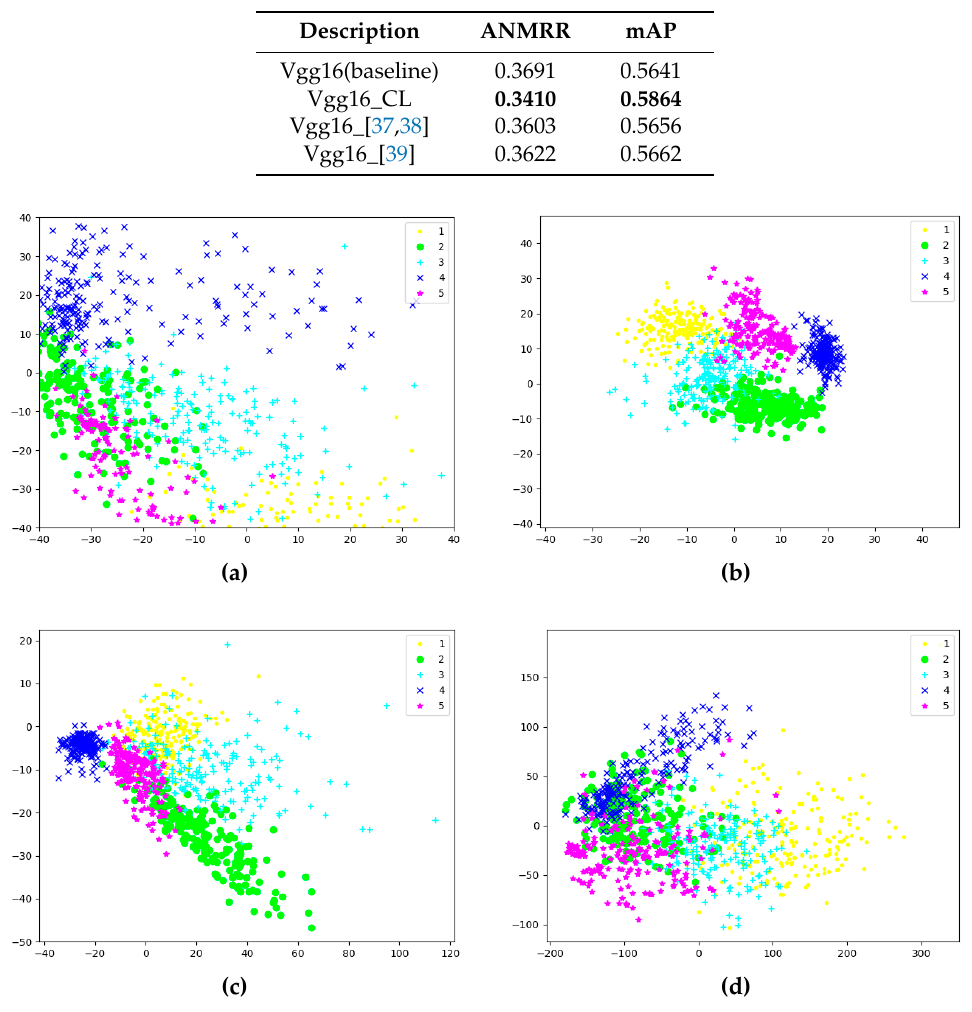
Table 4. Comparisons of the different loss functions. The best result is reported in bold.